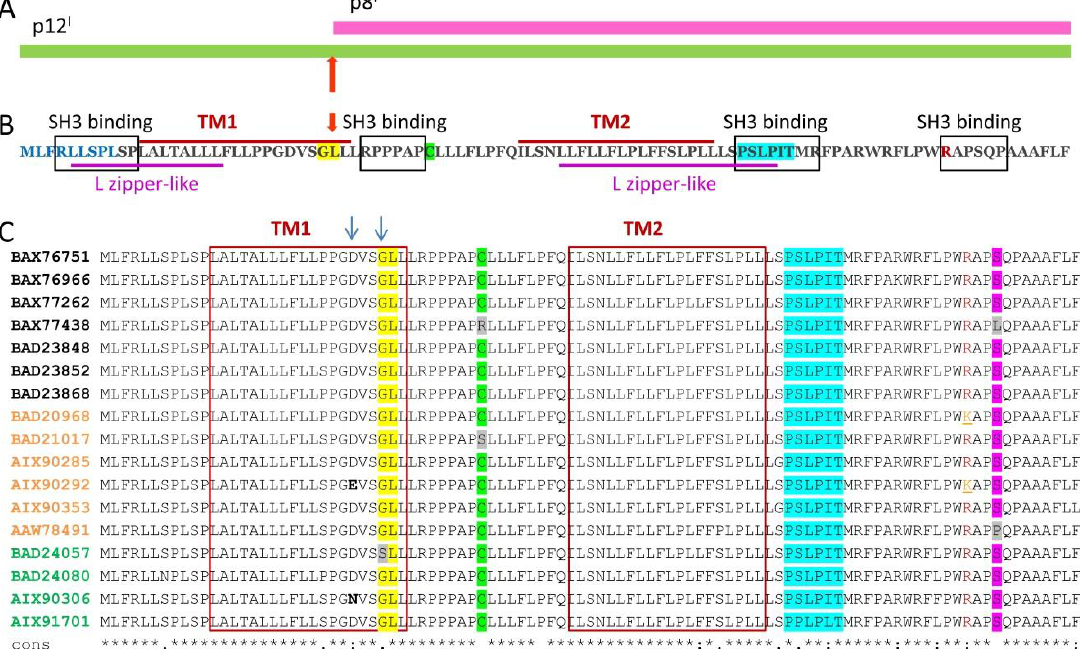
Figure 1. p12 I and p8 I proteins’ organization: ( A ) p8 I is a proteolytic product of 12I; the proteolytic cleavage site G29/L30 is indicated with an arrow; ( B ) aa sequence and putative domain architecture of full length p12 I are shown: The endoplasmic reticulum (ER) retention N-terminal sequence is in blue; The transmembrane helices TM1 and TM2 are designated with red bars above the sequence; SH3 binding motifs are in black rectangles; L zipper-like motifs are underlined in magenta; R88 is in red; the G29/L30 cleavage site is highlighted in yellow and indicated by a red arrow. ( C ) Alignment of multiple aa sequences of p12 I from randomly selected HTLV-1 strains, which were isolated from human carriers: Protein identification numbers in black, orange and green are from patients with adult T-cell leukemia/lymphoma (ATLL), patients with HTLV-1-associated myelopathy/tropical spastic paraparesis (HAM/TSP) and asymptomatic carriers, respectively. Conserved aa are indicated with asterisks under the sequences; residues D26 and G29 and their substitutions that are relevant to the level of p12 I and p8 I co-expression, are indicated with arrows; the cleavage site G29/L30, C39, the calcineurin binding motif, and residue S91, which is frequently mutated to other aa (mostly to P91), are highlighted in yellow, green blue, and magenta respectively; TM1 and TM2 are in red rectangles. The substitutions G29S, C39S, C39R, S91L, and S91P are highlighted in grey; R88 and K88 are in red and orange, respectively. T-COFFEE Multiple Sequence Alignment software was used.